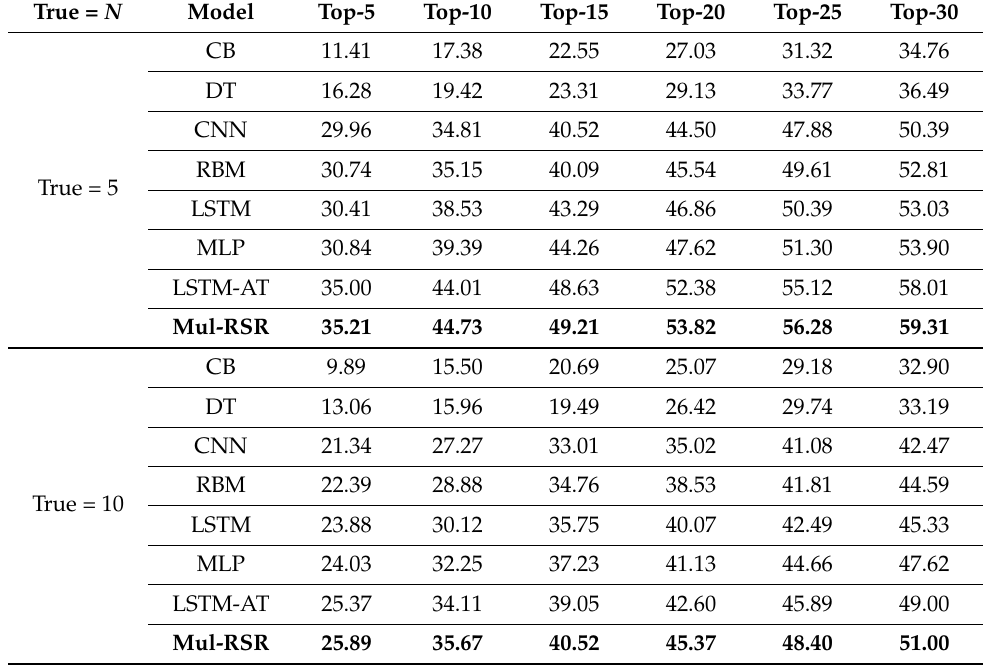
Figure 5. Error of each recommendation model. Table 3. HitRate (%) result of recommendation